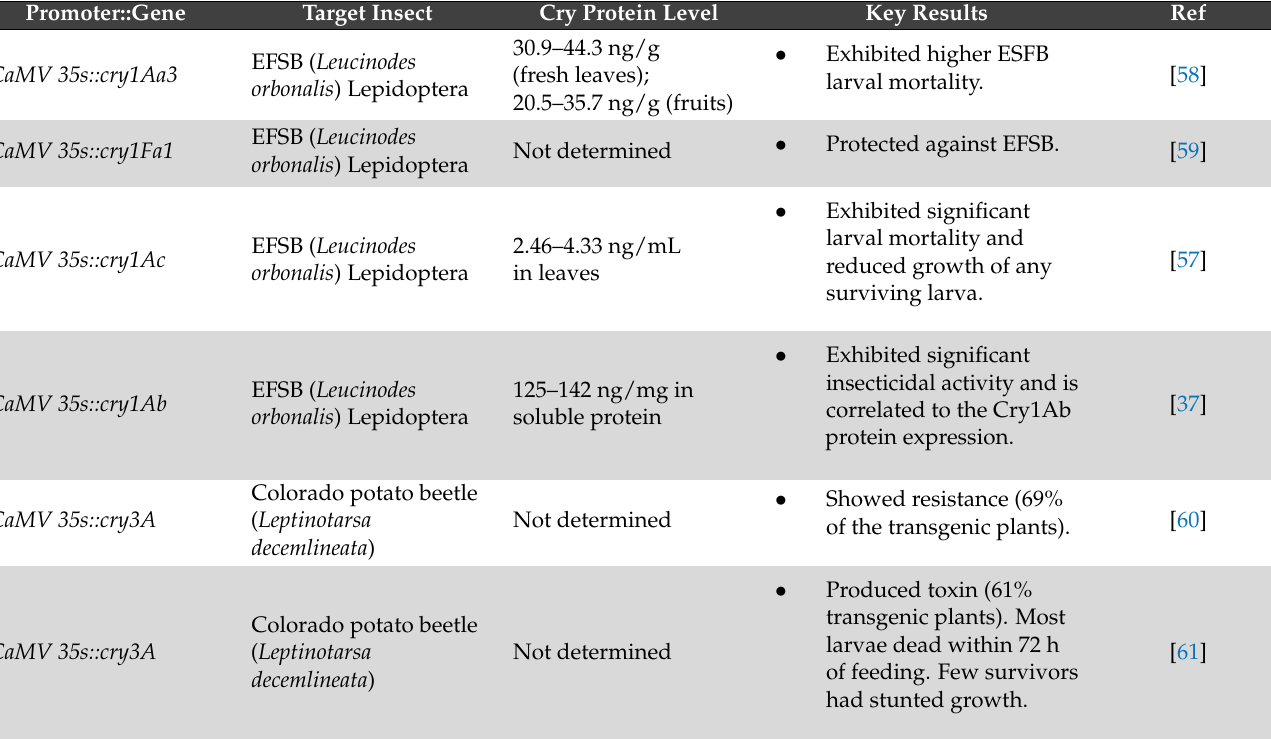
Table 3. Insect resistant transgenic